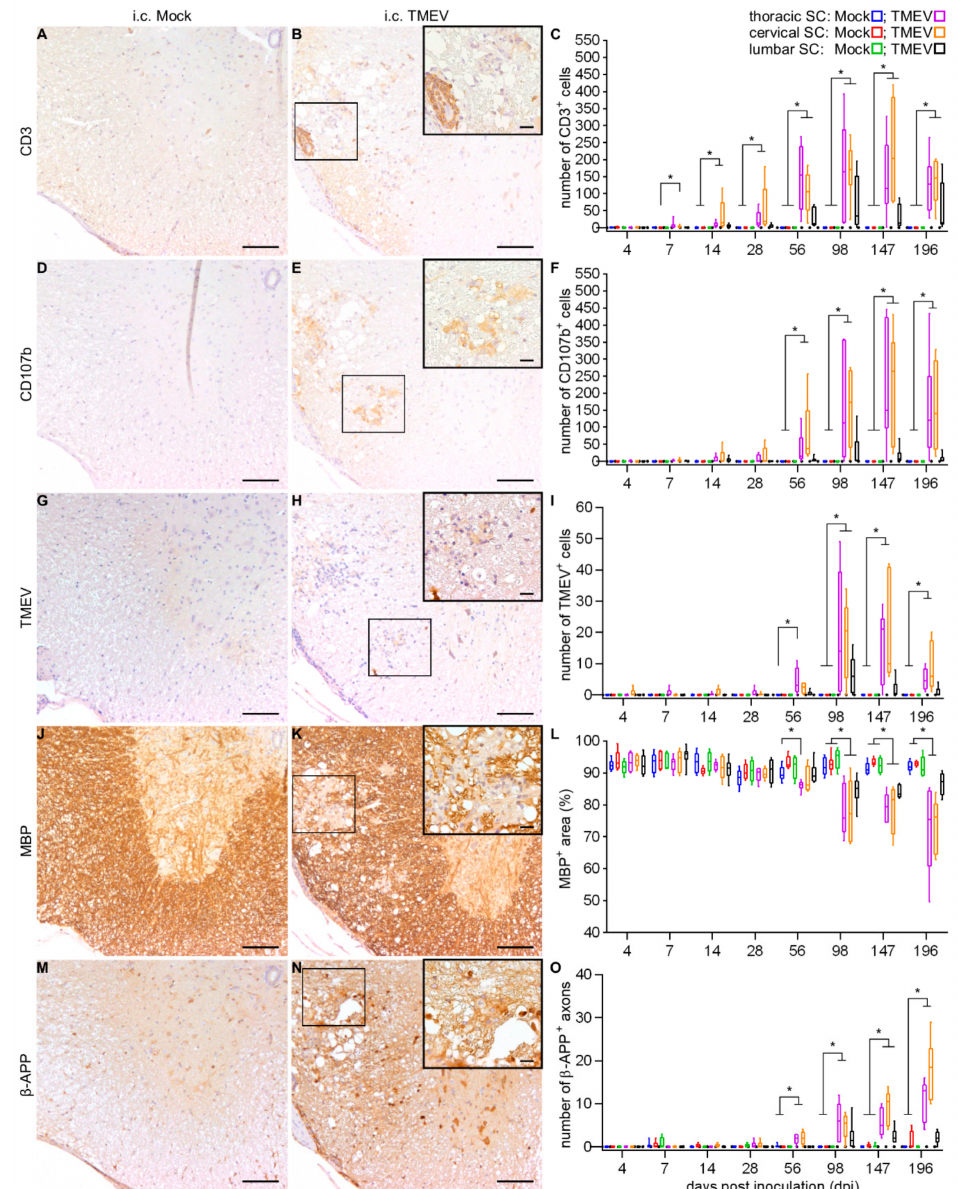
Figure 8. Detection and quantification of the SC lesion following i.c. TMEV infection / mock-injection. Immunophenotyping of inflammatory cells as well as detection of virus protein, demyelination and axonal damage at 56 dpi within the thoracic SC following i.c. mock-injection ( A , D , G , J , M ) and TMEV infection ( B , E , H , K , N ). Statistical analysis revealed a significantly increasing number of CD3 + T lymphocytes followed by an increased number of CD107b + microglia / macrophages ( C , F ). The presence of virus protein ( I ), as well as progressive demyelination ( L ) and axonal damage ( O ) starting at 56 dpi were detected following i.c. TMEV infection. Box-and-whisker plots show median and quartiles. Significant di ff erences between the groups as detected by a Mann–Whitney U-test are indicated by asterisks (* p < 0.05). Bars represent 100 µ m in the overviews and 20 µ m in the